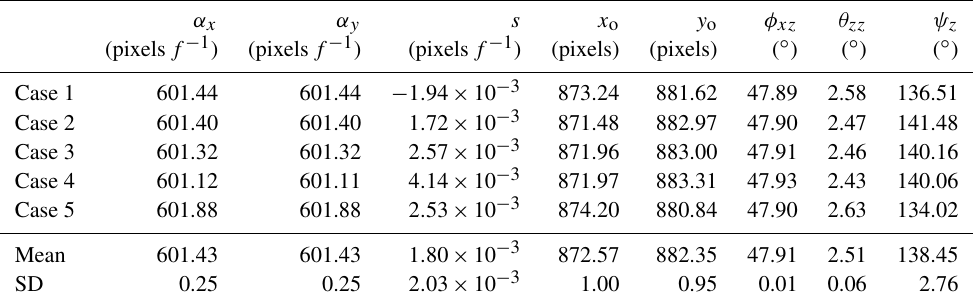
Table 2. Camera model parameters (excluding distortion terms) determined from the five test cases of solar input data. The mean and standard deviation are also given. The units denoted [pixels f − 1 ] is pixels per focal